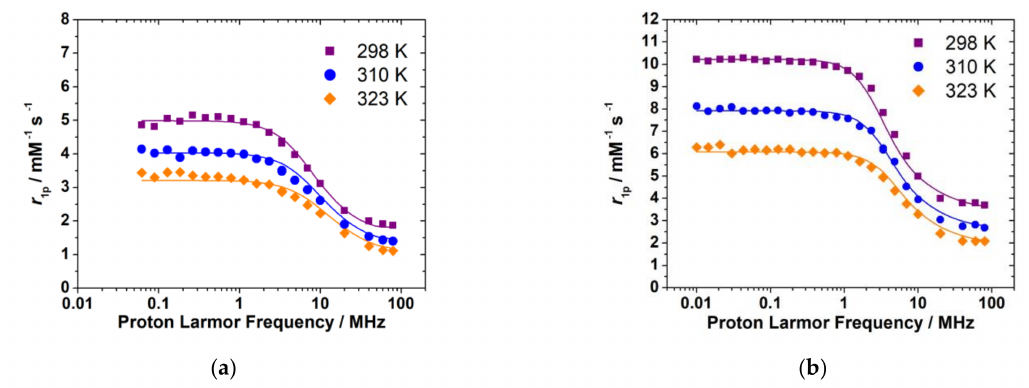
Figure 5. 1 H nuclear magnetic relaxation dispersion (NMRD) profiles recorded at different temperatures for the Mn(II) complexes of t O2DO2A 2 − (( a ), pH 7.4) and t O2DO2AM Pip (( b ), pH 7.4). The solid lines correspond to the fits of the data as described in the